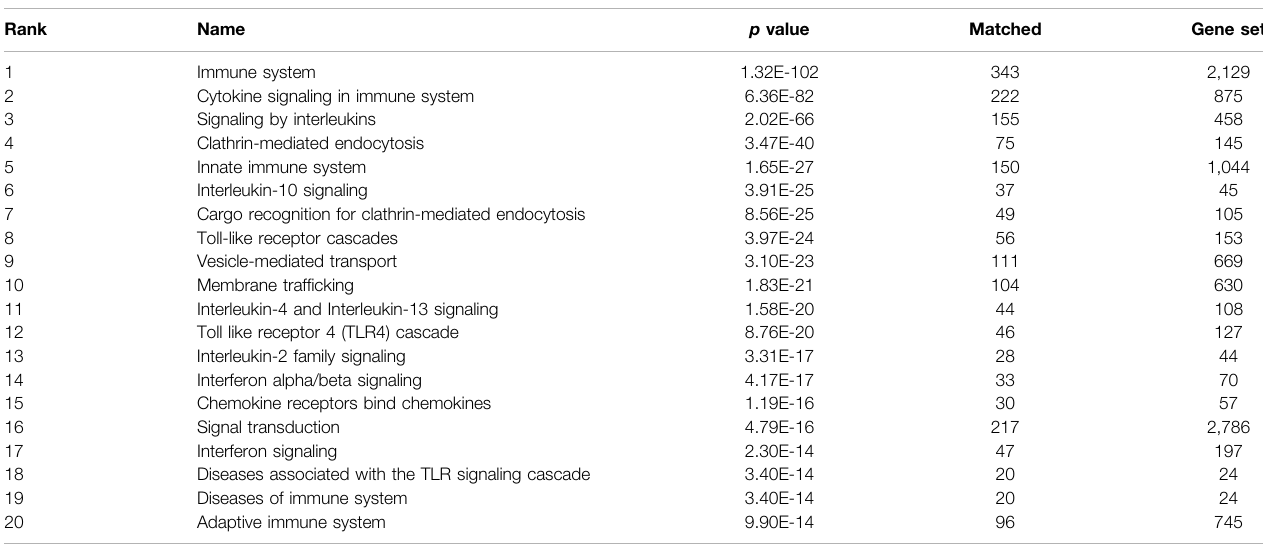
TABLE 2 | Top 20 enriched biological pathways (Reactome) in the fi nal